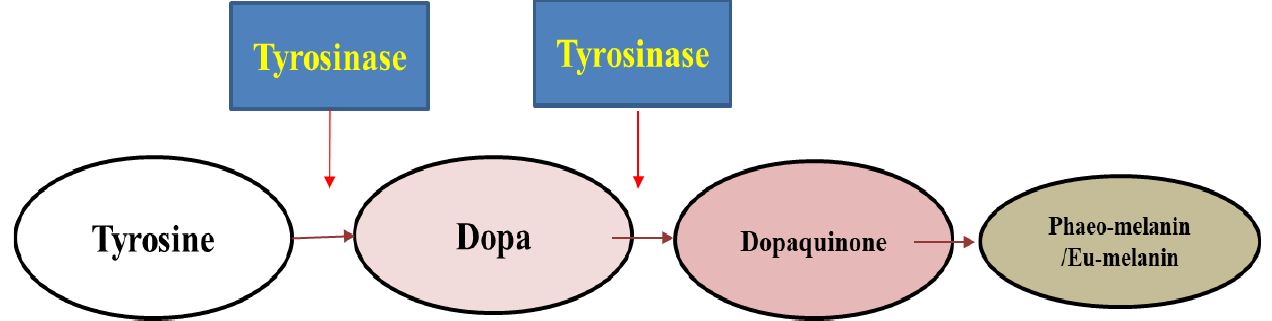
Figure 1. Conversion of tyrosine into melanin in presence of tyrosinase enzyme (tyrosine to melanin conversion pathway) [19].